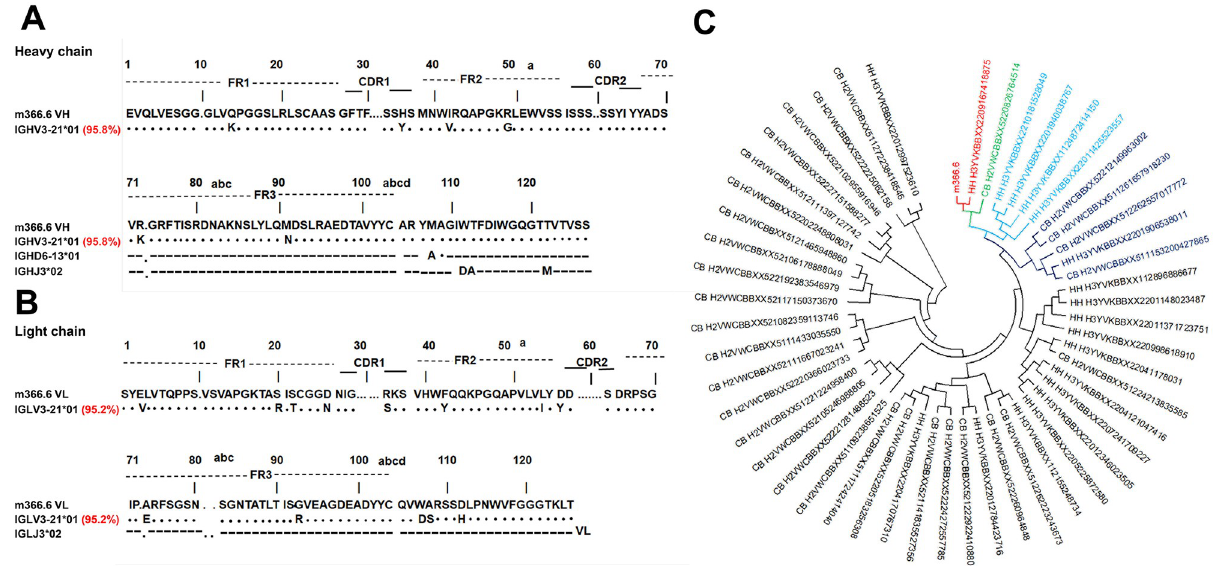
Fig 4. Immunogenetic analysis of m366.6. Immunogenetic analysis of the heavy- (A) and light-chain (B) variable regions of m366.6 using the IMGT tool. (C) Germline-rooted circular phylogenetic tree of m366.6-like antibody sequences found in IgM libraries derived from healthy human adults and neonates. The m366.6 and a sequence showed highest similarity to m366.6 were shown in red. Sequence ID started with CB represents sequence derived from the neonates, and that started with HH represents sequence derived from the healthy adults. The phylogenetic tree was constructed by the Neighbor-Joining